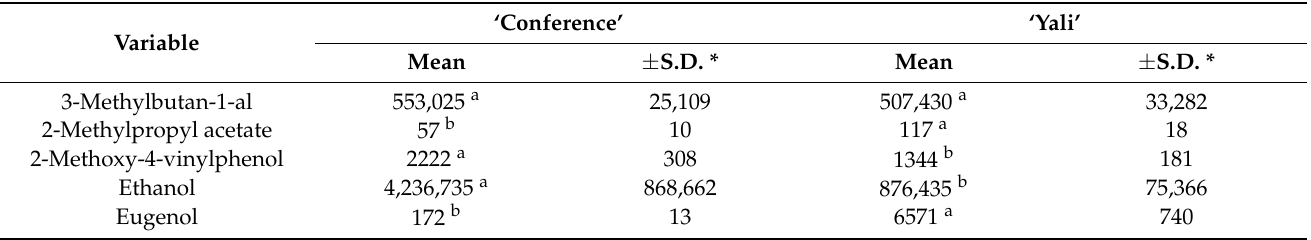
Table 4. Initial contents of significant volatiles (ng kg -1 ) distinguishing the storage regimes of pear cultivars ‘Conference’ and ‘Yali’ at 20 °C.